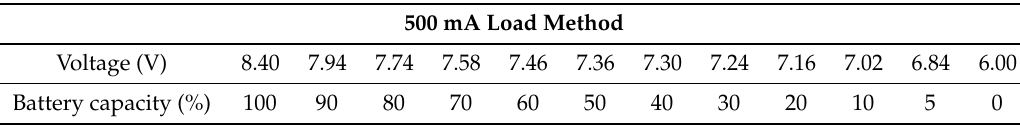
Table 4. Correspondence of voltage and battery capacity.